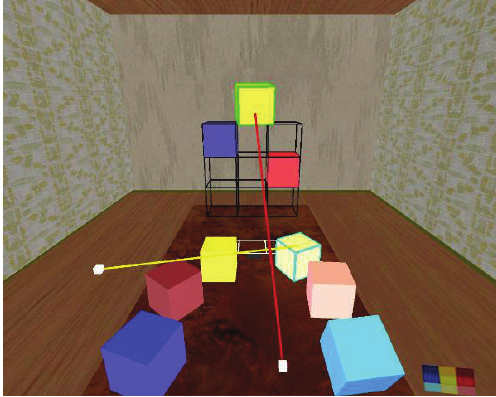
Figure 1: Virtual environment used.